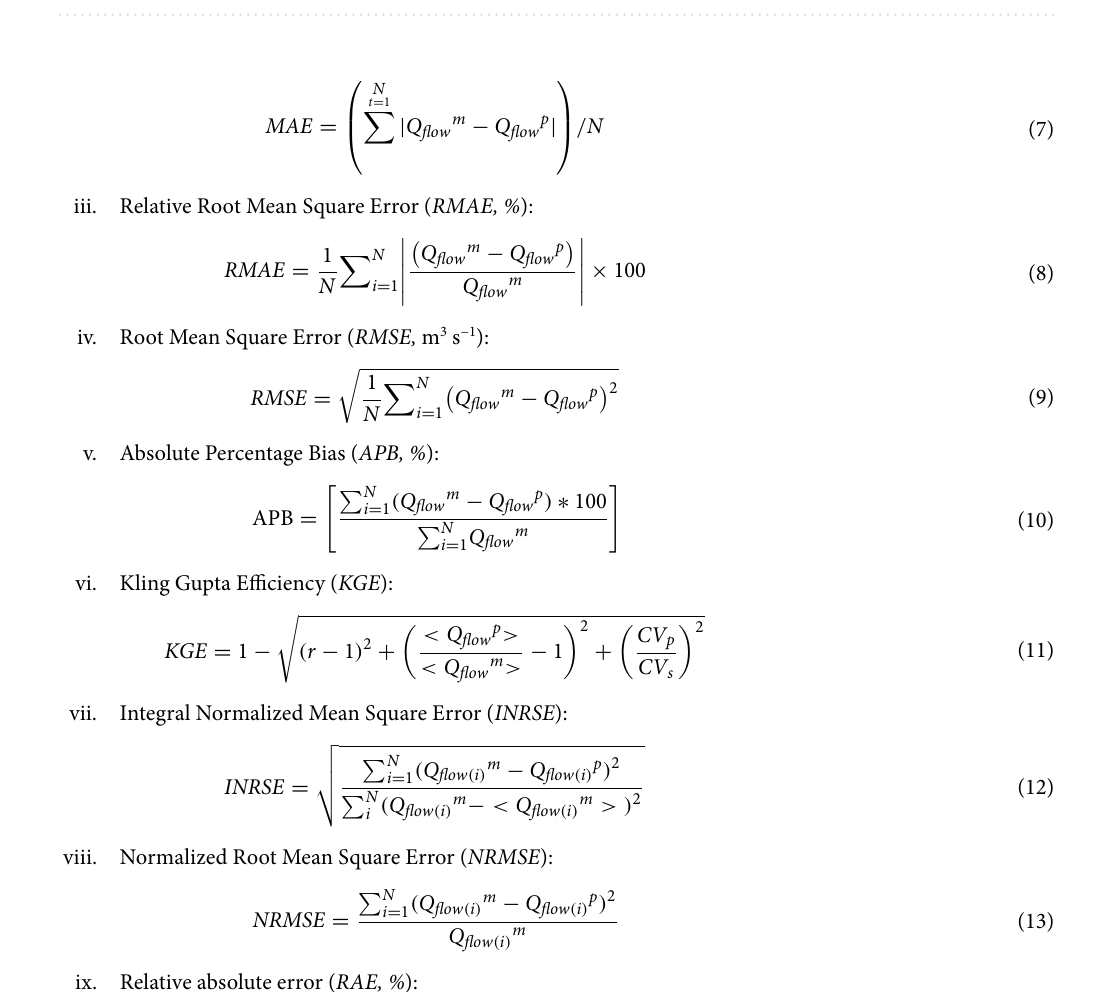
Table 3. The architecture of Deep learning (DL) models (Convolutional Neural Network (CNN), Long Short Term Memory Network (LSTM), Deep Neural Network (DNN), and the respective backpropagation algorithm used in the DL model development for Brisbane River and Teewah Creek streamflow ( Q , m 3 s −1 ) prediction in hourly basis. ReLU stands for Rectified Linear Units. α = Learning rate, the proportion that weights are updated, e = Is a very small number to prevent any division by zero in the model implementation, b 1 = The exponential decay rate for the 1st moment estimates, b 2 = The exponential decay rate for the 2nd moment